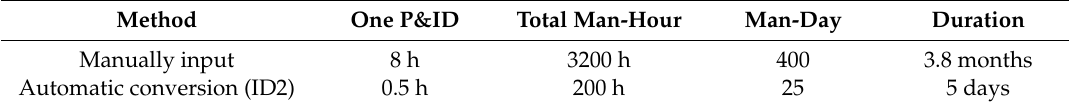
Table 2. Comparison of man-hours and duration between manual drawing and automatic recognition